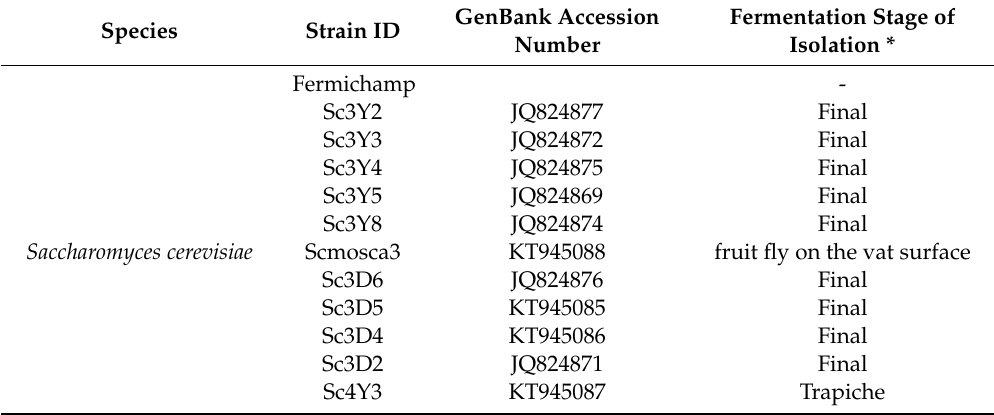
Table 1. Molecular identification and mezcal fermentation stage of isolation of the yeasts used in this